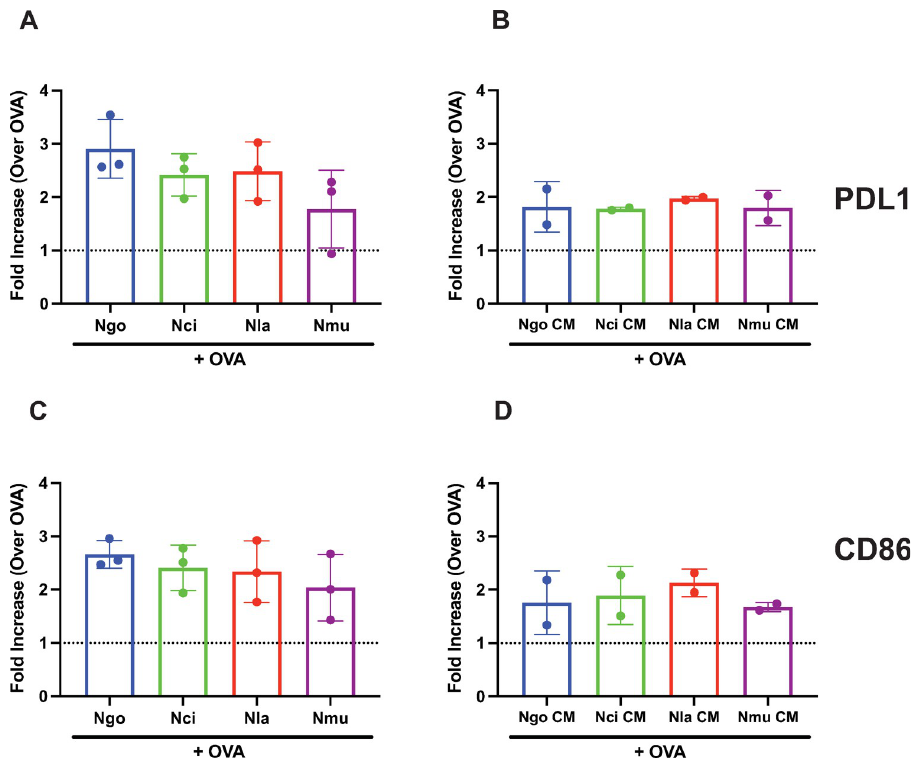
Fig 5. Live bacteria and conditioned medium prepared from four Neisseria species up-regulated expression of dendritic cell surface markers. Dendritic cells were exposed to whole live bacteria (A, B) or conditioned medium (C, D) in the presence of OVA for 24 hours and the expression of PDL1 (A, C) and CD86 (B, D) were quantified by flow cytometric analysis. The bar graphs represent the fold change in mean fluorescence intensity (MFI) for each condition compared to OVA-treatment alone. Ngo (bacteria or CM) + OVA (blue), Nci (bacteria or CM) + OVA (green), Nmu (bacteria or CM) + OVA (yellow), or Nla (bacteria or CM) + OVA (red). The fold increase in MFI was calculated as the mean of 2 independent